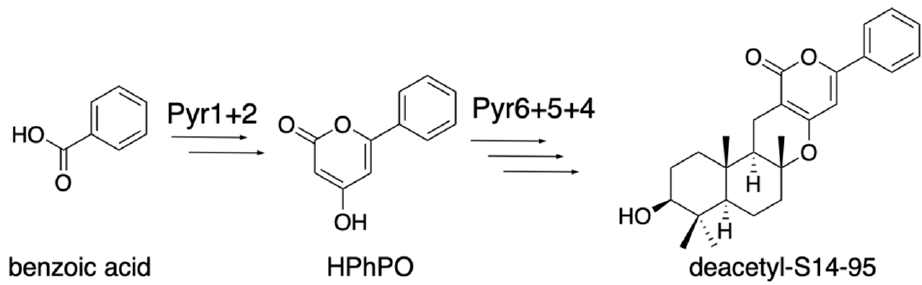
Figure 3. Un-natural product synthesis from benzoic acid with Pyr12456.